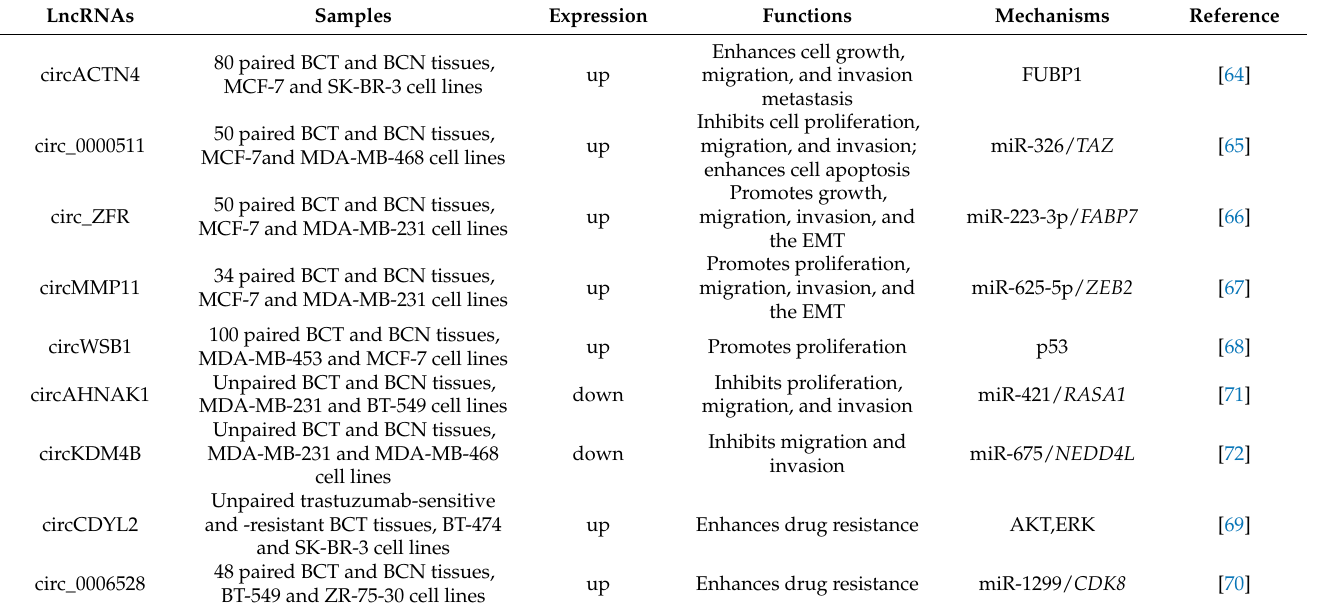
Table 2. Regulatory roles of representative circRNAs in breast